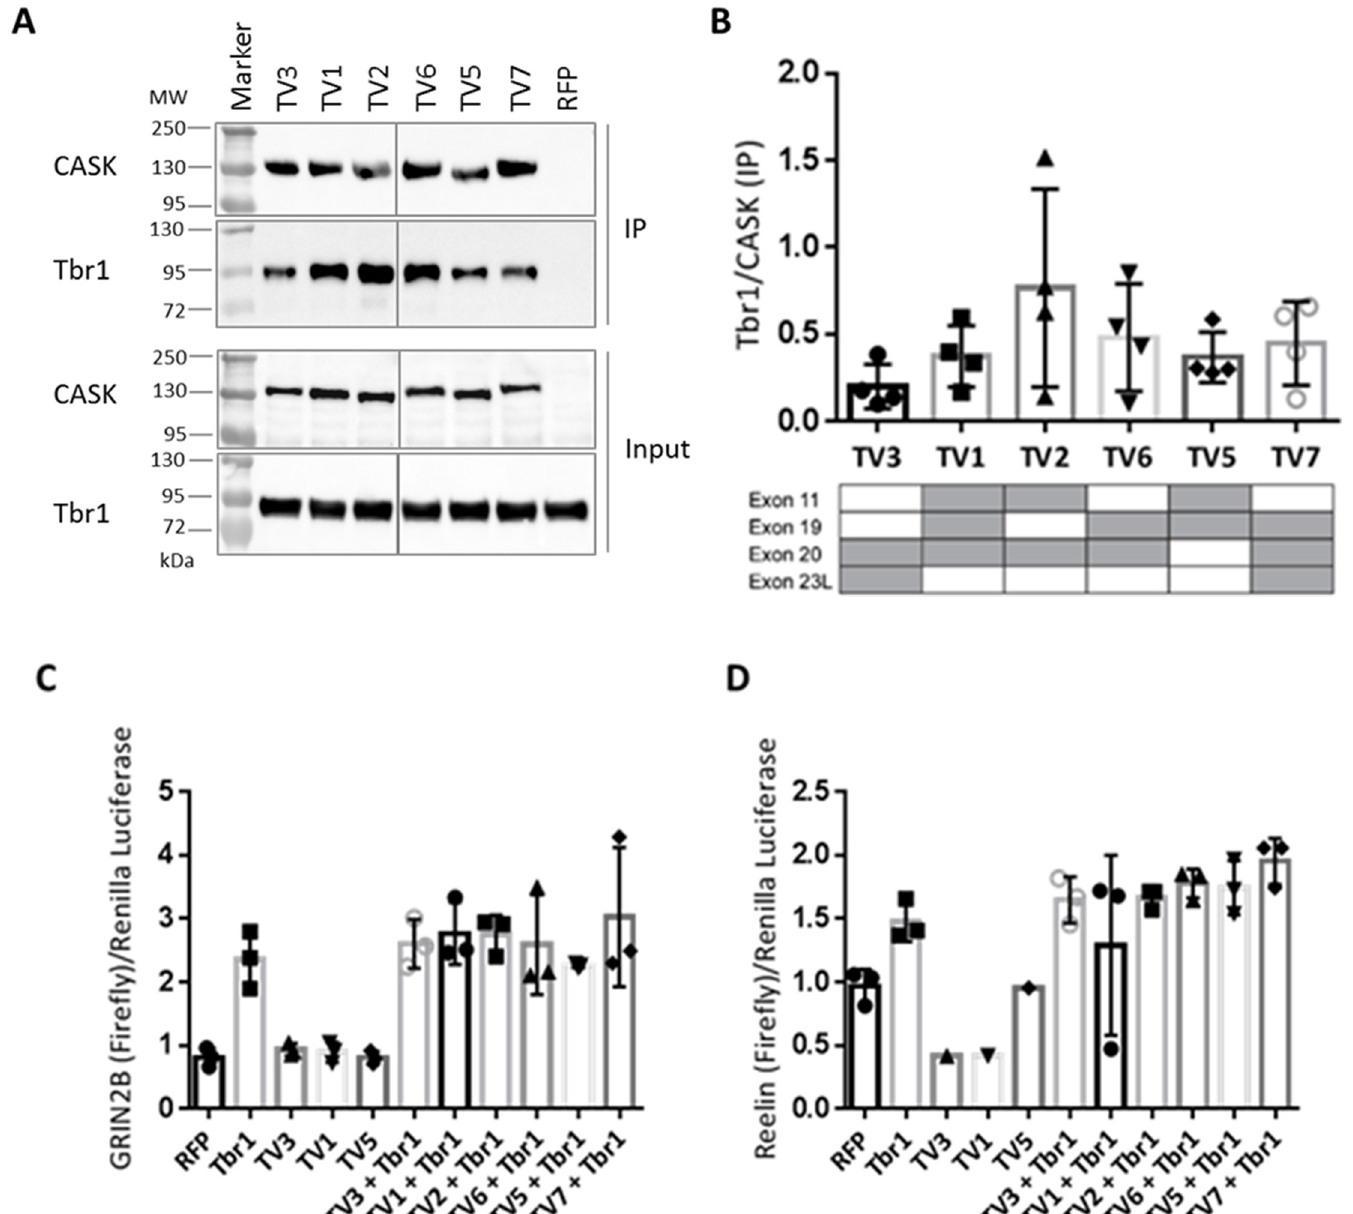
Fig 4. CASK TV2 is the preferred binding partner of Tbr1. A: HEK293-T cells expressing mRFP-tagged CASK variants (TV1-TV7; TV4 not present), or mRFP as a negative control, in combination with Myc-tagged Tbr1 were lysed in RIPA buffer 24 h after transfection. Using a RFP-Trap matrix RFP-CASK as well as bound Tbr1 were immunoprecipitated. The input and precipitate (IP) samples were analyzed by western blot, followed by detection with specific α -CASK and α -Myc antibodies. The protein bands were visualized by chemoluminescence using an imaging system (BioRad). The presents of alternatively spliced exons are indicated by grey colour in tables below the respective bar graphs. All samples were run and analyzed on the same gel/blot, and intervening lanes with non-relevant samples are not shown. B: CASK and Tbr1 IP bands were quantified and Tbr1 signals were normalized to CASK signals as a measure of binding strength of each CASK variant. Four independent experiments were performed and the means ± SD are shown. CASK variant two (TV2) bound stronger to Tbr1 compared to the remaining variants, though this difference did not reach significance after four repeats. One-way ANOVA with Tukey´s multiple comparison test. C: HEK293-T cells expressing firefly luciferase driven by the GRIN2B promotor, Renilla luciferase under control of a CMV promotor and Tbr1 and CASK variants as indicated were lysed and the activity of both luciferases was determined using a dual luciferase assay kit. For quantification, the ratio of firefly to Renilla signal intensities was calculated for each condition. Upon Tbr1 expression, an increase of promotor activity was induced, which could not be increased further by coexpression of any CASK variant. D: Luciferase reporter assays were performed as in C, using the firefly luciferase expression under control of the REELIN promoter.